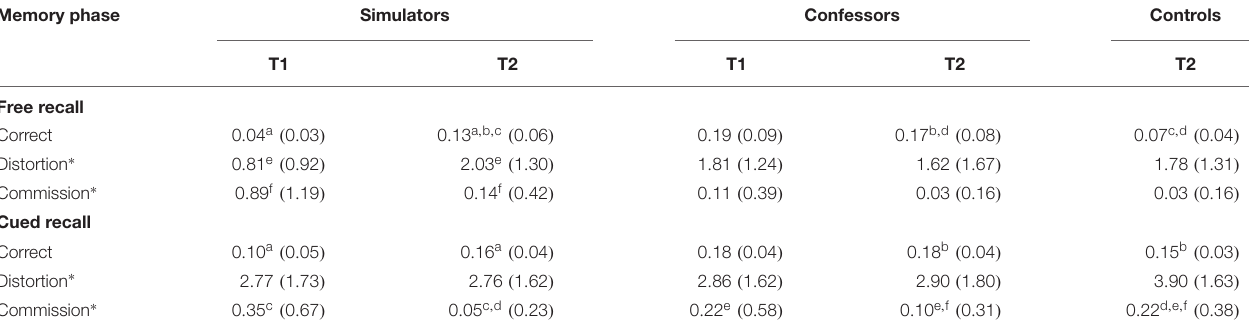
TABLE 1 | Free and cued recall proportions for each condition during the first (T1) and the second (T2) memory